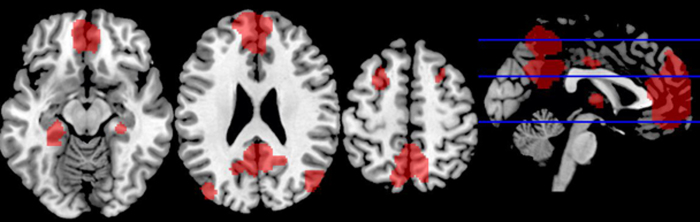
DMN template mask.